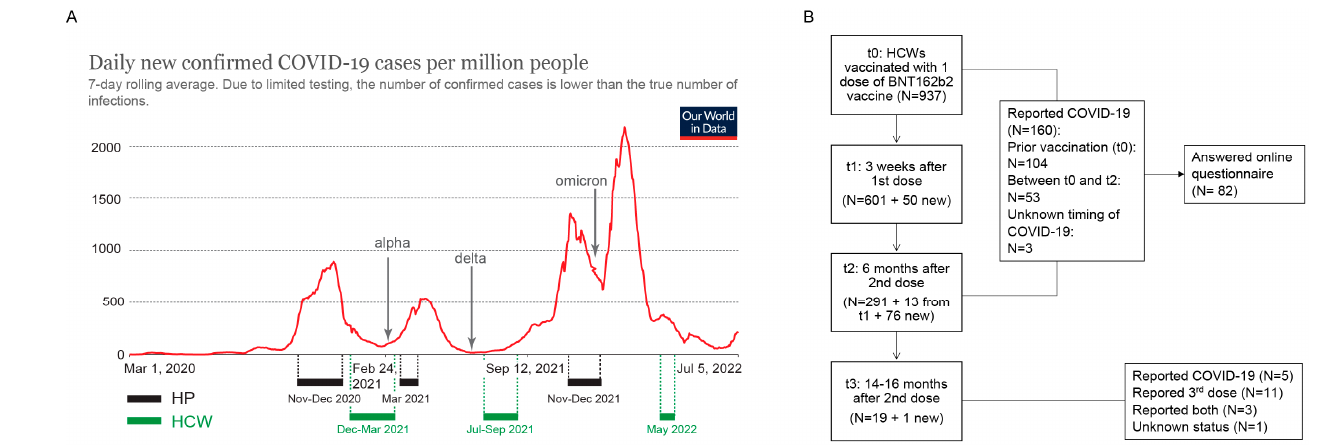
Figure 1. Timeline of serum samples collection and flowchart of HCW cohort enrolment. ( A ) Intervals of sera collection for hospitalized patients (HP) and healthcare workers (HCW) in relation to COVID-19 pandemic waves in Croatia. ( B ) Flowchart of HCWs enrolment, follow-up and COVID-19 status. Image in ( A ) adjusted from Our World in Data.